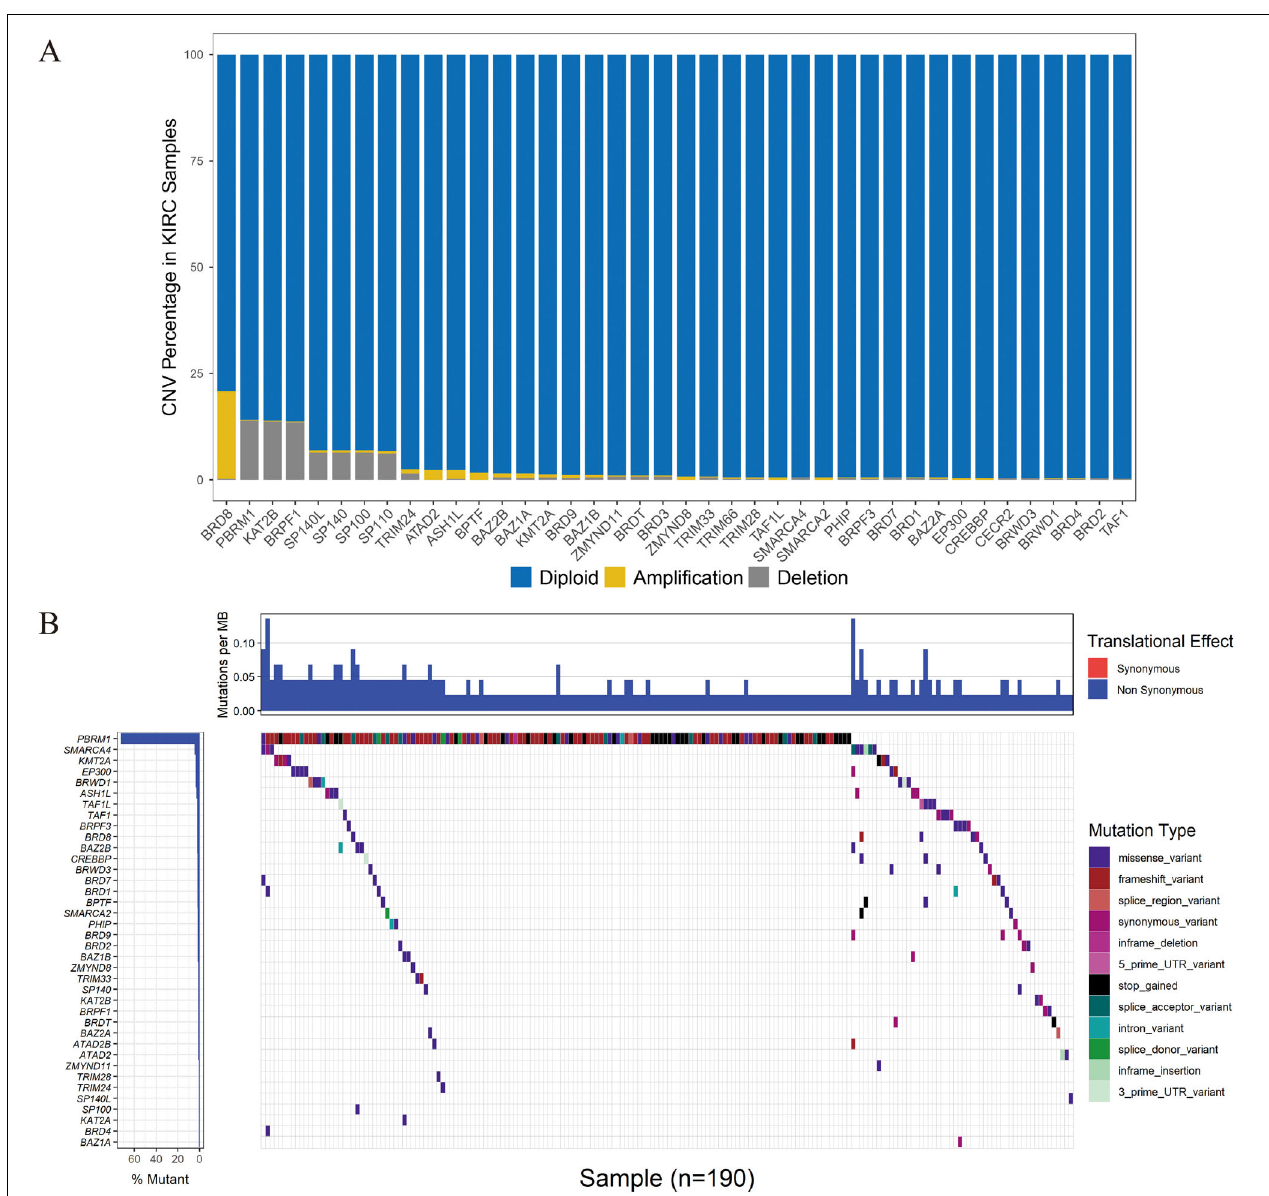
FIGURE 3 | CNV and SNP analysis of the seven BRD genes in the signature. (A) The percentage of patients with CNVs. (B) SNPs of the BRD genes were observed in 336 patients.